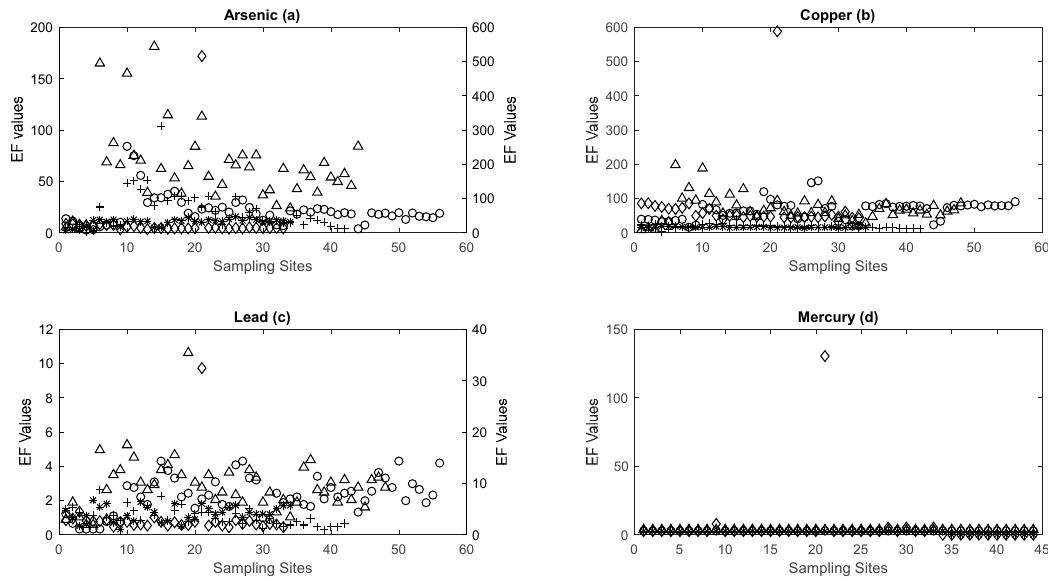
Figure 3. Downstream longitudinal sequence of EF for ( a ) As; ( b ) Cu; ( c ) Pb, and ( d ) Hg.